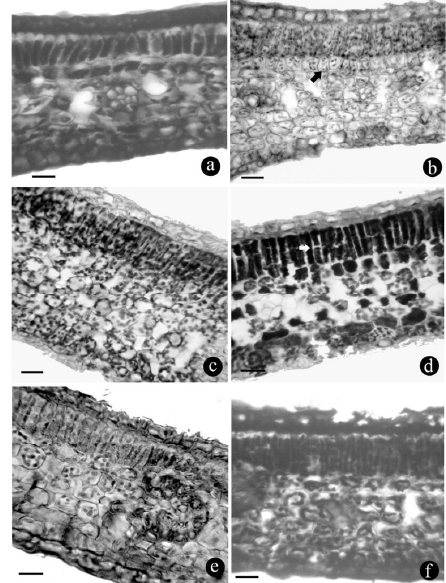
Fig. 1. Anatomical features of the leaf lamina in M. indica, magnification bar, a to f - 10 mm a. ‘Cowasji’- single layered palisade, spongy layer cells compactly arranged; b. ‘Batli’- single layered pallisade, a continuous layer of spongy compact cells below pallisade (arrow); c. ‘Jhumakhiya 1’- single layered pallisade, spongy layer compactly arranged; d. ‘Sindoria’- two layer pallisade (arrow), spongy layer compact; e. ‘Pairi’- single layered pallisade, spongy layer compact, rhomboidal crystal near vascular bundle; f. ‘Goto’- single pallisade, spongy layer cells loosely Table 1. Qualitative and quantitative internal features of lamina (mean ± SD) (a-adaxial, b- abaxial, Rh- rhomboidal, Sp- sphaeraphides) No.